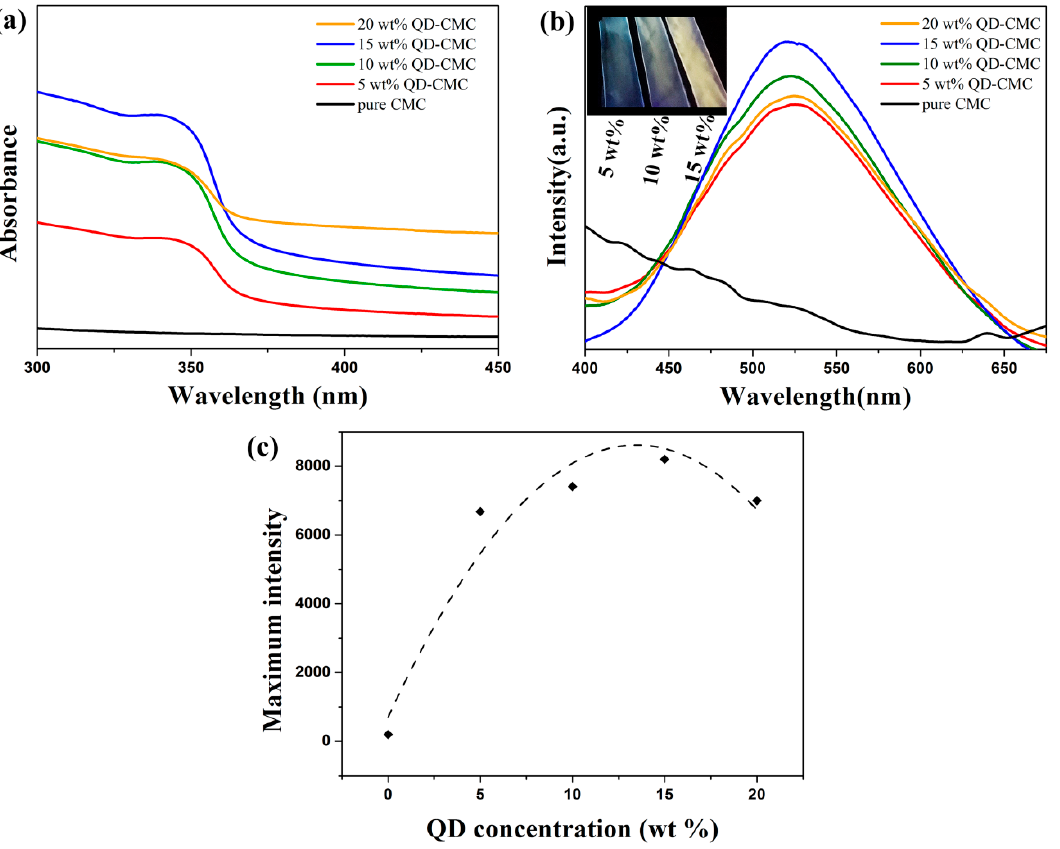
Figure 6. ( a ) UV-vis spectra and ( b ) photoluminescence spectra (ex = 350 nm) of pure CMC and composites. Inset in ( b ) is digital photographs of ZnOQD/CMC nanocomposite films under 365 nm UV lamp. ( c ) Maximum intensity of the photoluminescence spectra of ZnOQD/CMC nanocomposite films with different ZnOQD concentrations.